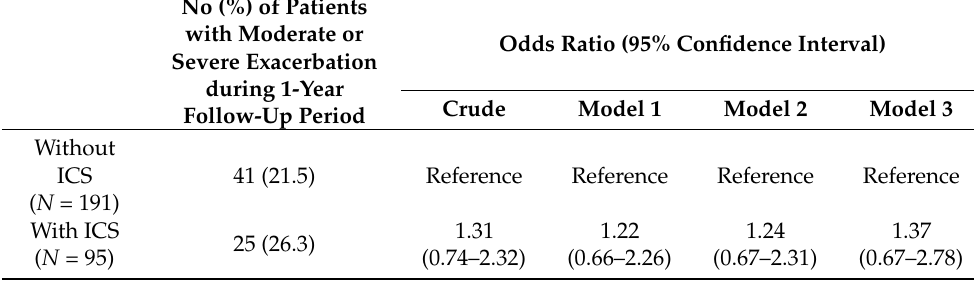
Table 2. Risk of moderate or severe exacerbation according to ICS